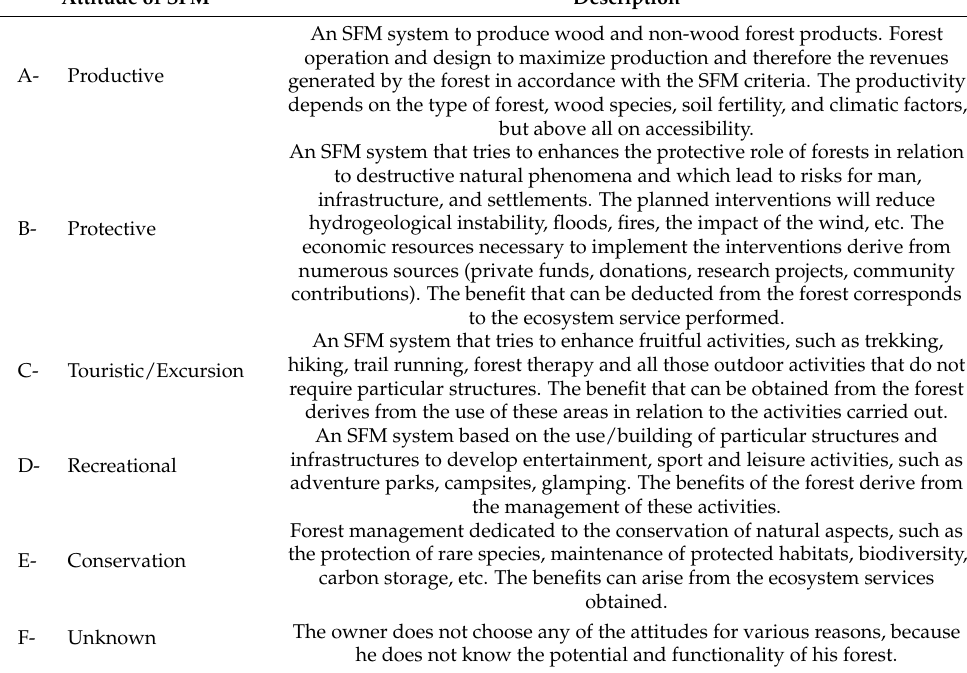
Table 1. Description of attitude of sustainable forest management system on the Forest Sharing ®